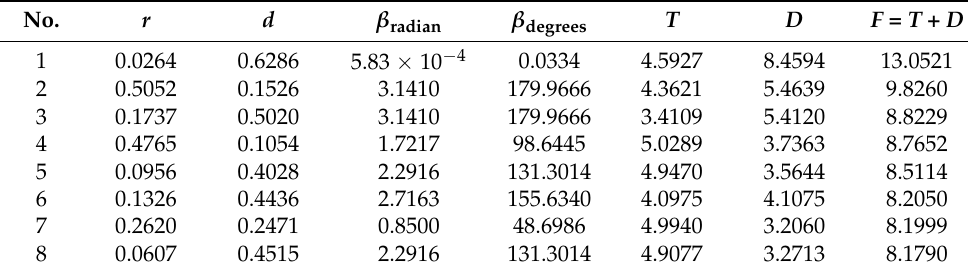
Table 2. Local maxima of the function F = T + D .